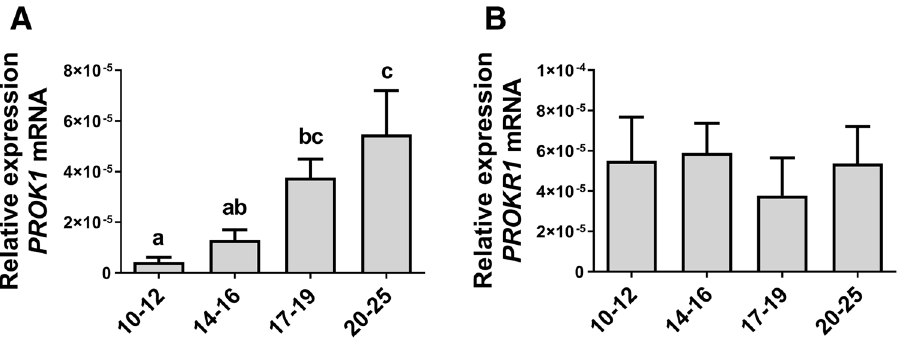
Figure 1. Expression of prokineticin 1 ( PROK1 ) mRNA is upregulated in the conceptus/trophoblast during embryo implantation and early placentation. The expression profiles of prokineticin 1 ( PROK1 ) ( A ) and prokineticin receptor 1 ( PROKR1 ) ( B ) mRNA in the porcine conceptus/trophoblast on days 10–12 (preimplantation stage; spherical and tubular forms), 14–16 (beginning of attachment/implantation; filamentous forms), 17–19 (implantation stage, filamentous forms) and 20–25 (chorion which originates from trophoblast, the onset of placenta development) of pregnancy. Data are presented as means ± SEM. Different letters (a–c) indicate statistically significant differences ( P < 0.05). Means sharing at least one the same letter indicate no significant